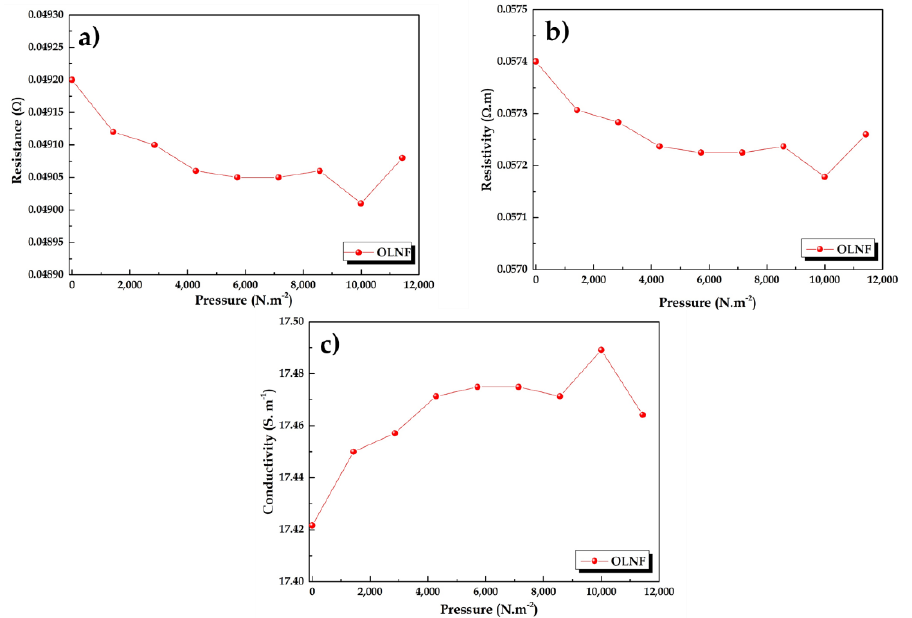
Figure 8. The variations of OLNF membranes in terms of ( a ) resistance, ( b ) resistivity, and ( c ) con- ductivity with reference to applied pressure.